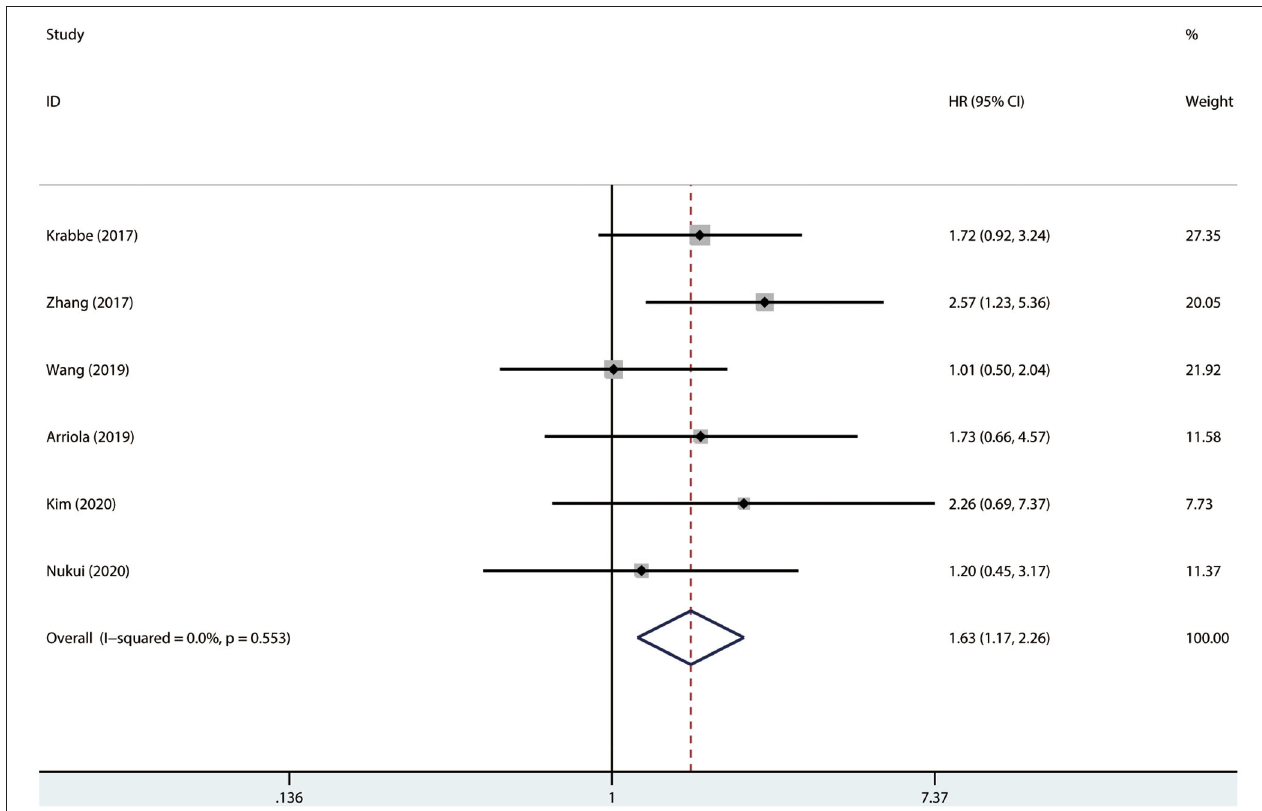
FIGURE 4 | Prognostic value of PD-L1 for CSS. CSS, cancer-specific survival; HR, hazard ratio; CI, confidence interval.